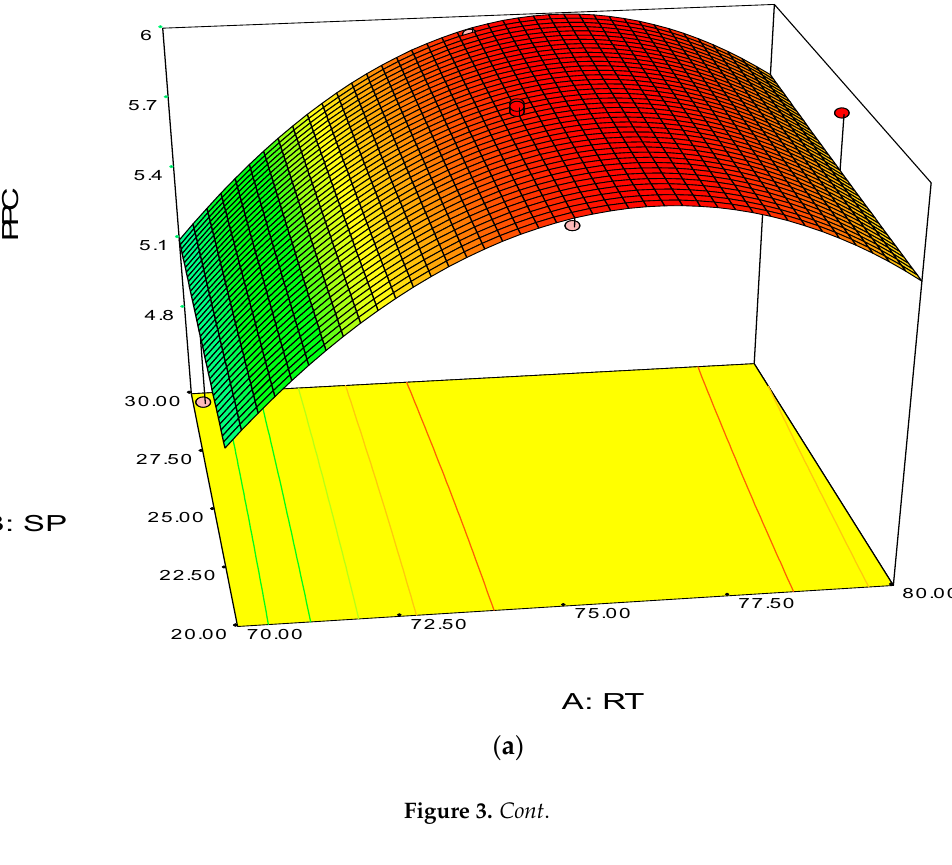
process parameters on the polymer conversion, when the other process parameter was fixed at their central points. Figure 3a,b shows the effect of temperature and pressure on the polymer conversion rate. The conversion rate showed a rising trend with increments of reaction temperature and system pressure, up to a certain level. From the response plot, the increment of response values can be clearly seen. At a temperature of 75 ˝ C the response point value is 5.98%, and when the temperature increased to 77.5 ˝ C, it gave the same response value. Further increments in temperature showed a decrease of response. The conclusion can be drawn that the optimum temperature is 75 ˝ C. However, most of the optimum responses values are at the 25 bar point, noticeable from the contour plots. At 25 bar the propylene polymerisation percentage response value remains at about 5.93%–5.98%. The increase in pressure above 25 bar does not show any significant improvement in the response value, whereas the optimum zone starts at 25 bar. In the literature, system pressure fluctuation has been described as an important parameter for olefin polymerisation with the fluidisation technique, as it can affect the bed dynamics [48]. Optimum fluidisation yield was studied by researchers at pressure ranges of 1–16 bar [49]. Experimental results reported a substantial boost in the total fluidisation performance with pressure increases up to 15 bar [50]. However, it is noteworthy that the reports were derived from lab-scale virtual analysis and were not results from real reaction conditions, and a minimum pressure of 20 bar is mandatory to produce industrial grade polypropylene [26].